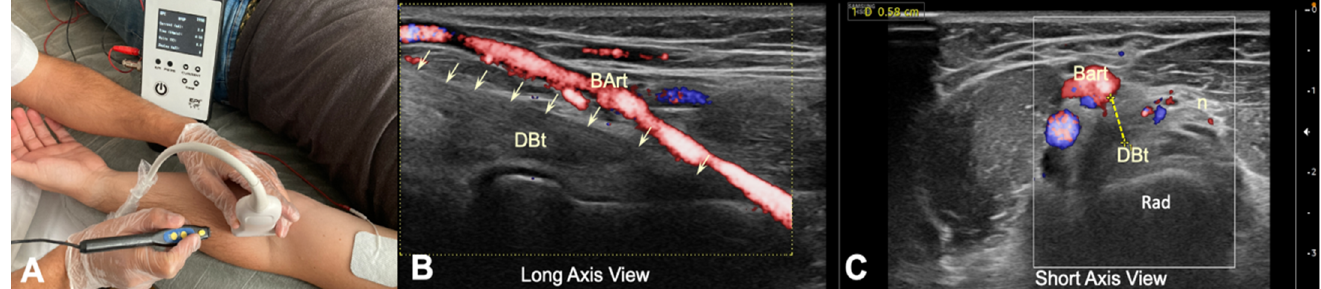
Figure 3. ( A ) Illustration of the percutaneous electrolysis approach with the elbow extended and supinated; ( B ) US imaging (Color Power Doppler) of the relationship between the brachial artery and the distal biceps tendon in long axis, with the elbow extended and supinated. ( C ) US image (Color Power Doppler) in short axis with the forearm supinated of the relationship and measurement of the brachial artery and median nerve to the tendon in a healthy volunteer. (DBt)-Distal Biceps Tendon, (Bart)-Brachial artery, (n)-Median nerve), (Rad)-Radial Tuberosity).